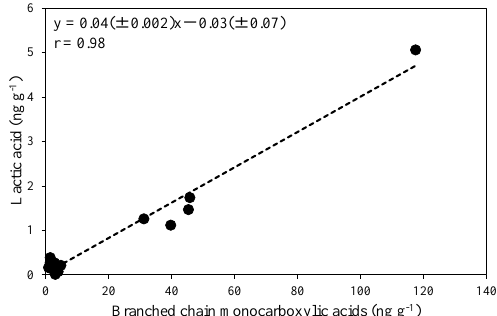
Figure 9. Scatter plot of concentrations of branched chain (iC 4 – iC 6 ) monocarboxylic acids vs. lactic acid in Mt. Tateyama snow samples. The dotted line represents the Deming linear